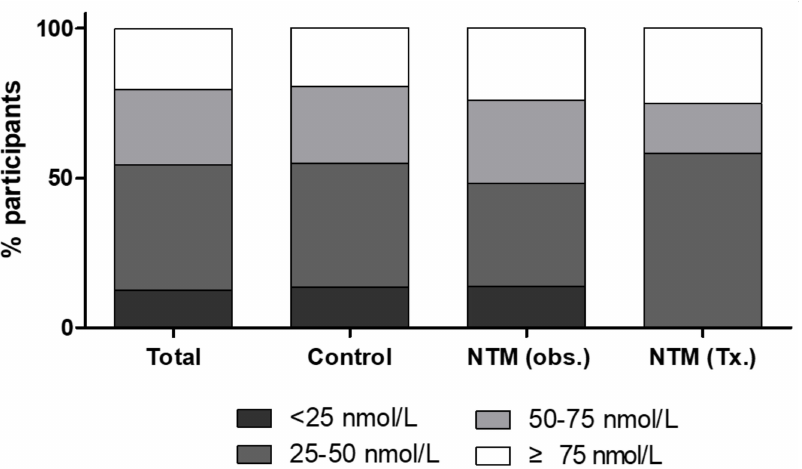
Figure 3. Distribution of vitamin D concentrations of patients with nontuberculous mycobac- terial (NTM) pulmonary disease and healthy controls; NTM, nontuberculous mycobacterium; obs, observation group; Tx, treatment group.